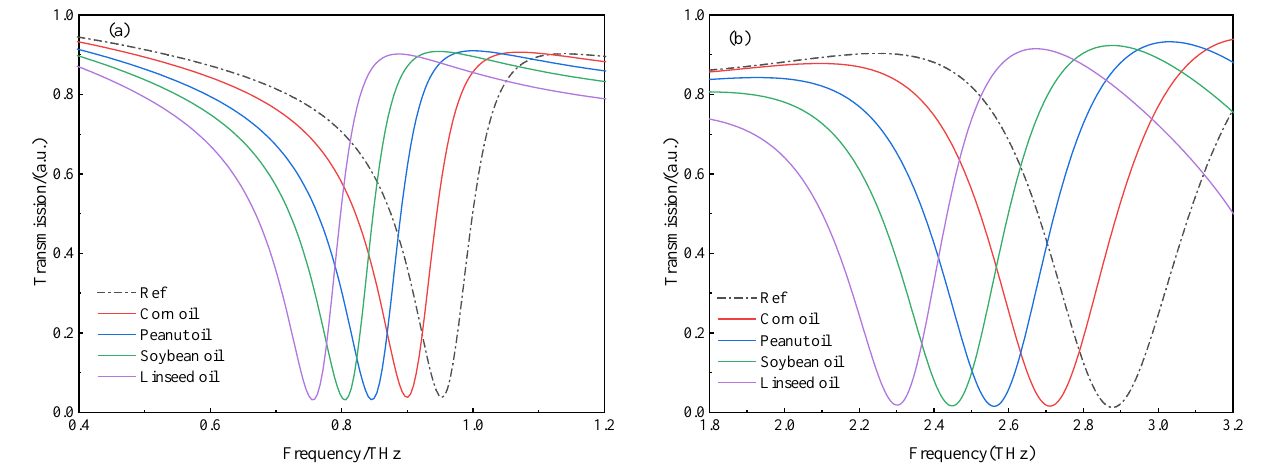
Figure 6. The frequency shift of the transmission spectra of the various types of edible oil at ( a ) f 1 and ( b ) f 2 . Table 2. Analysis results of the transmission spectra for edible oils detection using the proposed dual-band sample at different resonant modes were calculated by using Formula (4) according to the resonant peak offset of their transmission spectra, and compared with their standard re- n . fractive index ref